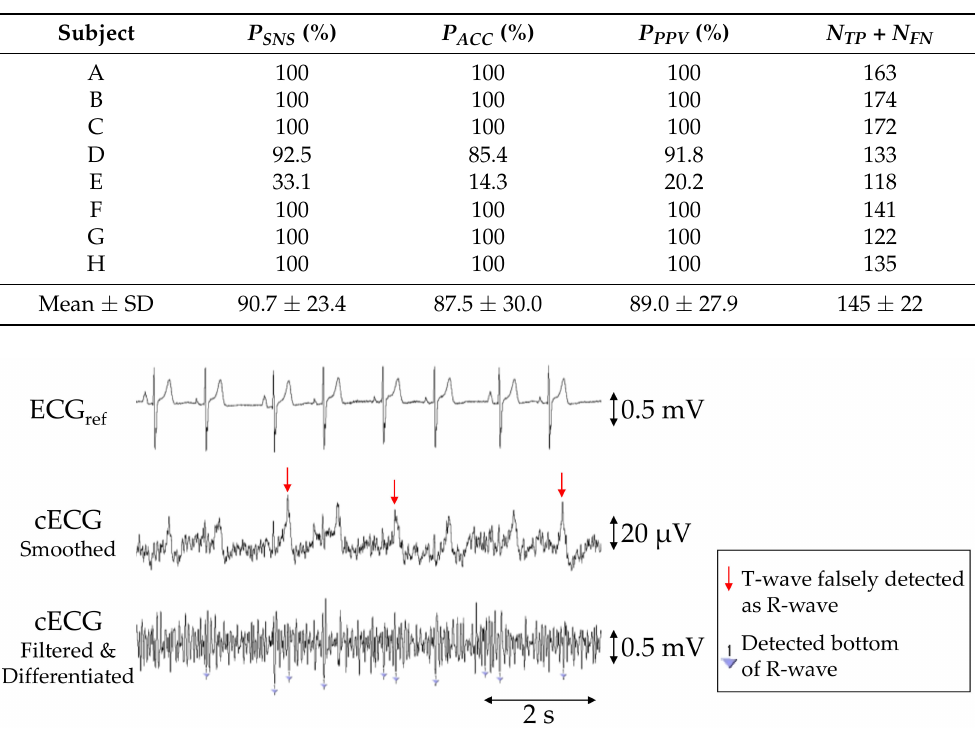
Figure 6. Simultaneous recordings of ECG ref , cECG and filtered and differentiated cECG of subject E obtained with the commercial system (first stage) or the proposed system (second and third stages) during the 2-min segment before the first two-cough experiment. Inverted triangles marks in the third stage show the detected bottoms of the